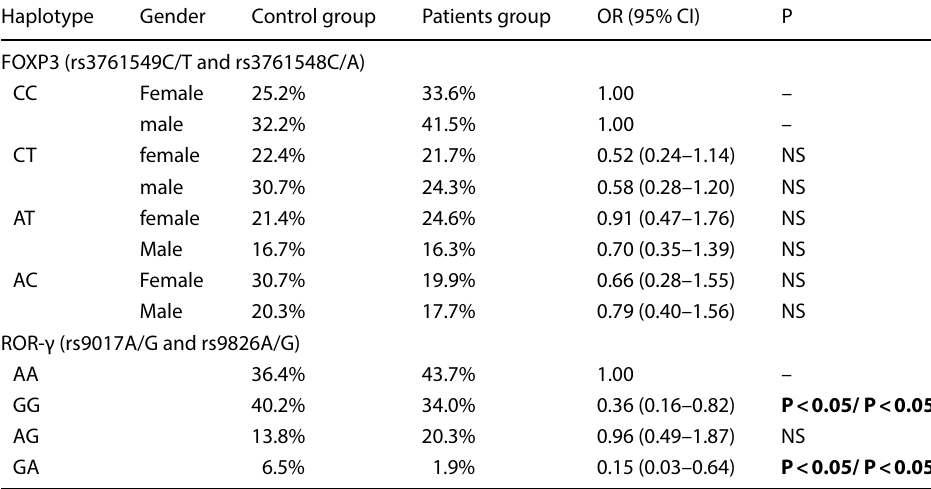
Bold refereed to significant values P p-value (significant), Pc p-value corrected, NS